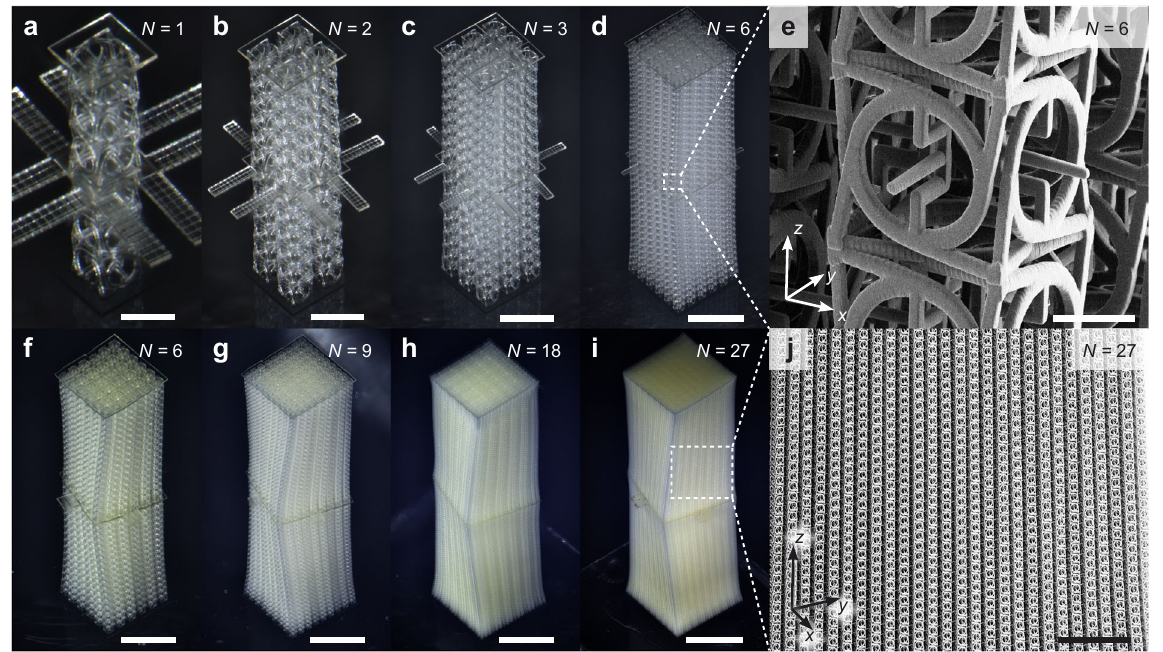
Fig. 4 Gallery of selected polymeric chiral tetragonal mechanical metamaterial samples following the design shown in Fig. 1. a – d Optical micrographs of samples with N = 1, 2, 3, 6 fabricated using the Nanoscribe 3D printer. a N = 1, scale bar: 100 µ m. b N = 2, scale bar: 200 µ m. c N = 3, scale bar 300 µ m. d N = 6, scale bar: 600 µ m. e Scanning electron micrograph of one unit cell of the sample with N = 6 depicted in d , scale bar: 40 µ m. f – i Optical micrographs of samples with N = 6, 9, 18, 27 fabricated using the multi-focus multi-photon 3D printer. f N = 6, scale bar: 300 µ m. g N = 9, scale bar: 450 µ m. h N = 18, scale bar: 900 µ m. i N = 27, scale bar: 1350 µ m. j Zoomed-in scanning electron micrograph of the sample with N = 27 depicted in i , scale bar: 300 µ N = N x = N y and N z = 3 N (hence sample height-to-width aspect ratio A = 2) in a chiral tetragonal metamaterial. Five independent data sets are depicted: (1) simple analytical model, (2) continuum fi nite-element microstructure calculations, (3) Timoshenko beam calculations, (4) Eringen micropolar continuum theory, and (5)